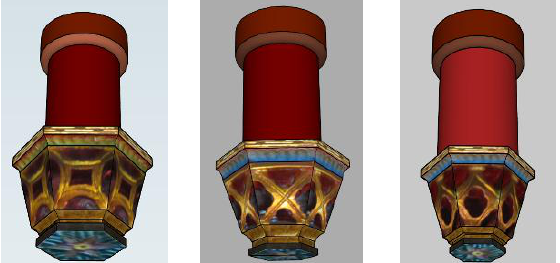
Figure 11. Component unit simulation: Diao-Tung